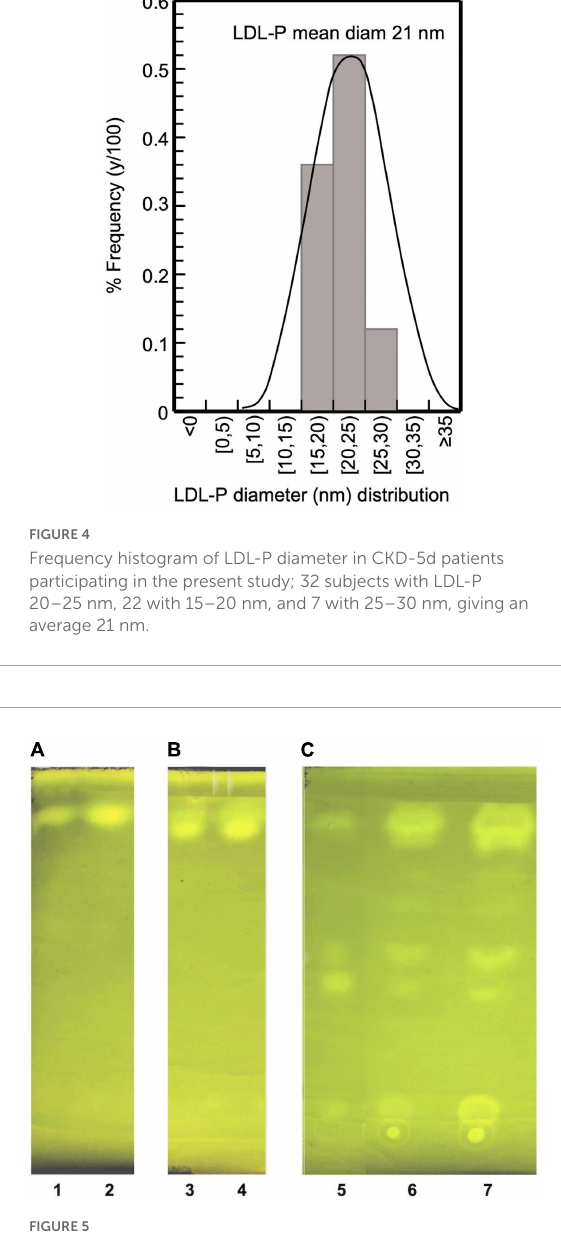
FIGURE5 Thin layer chromatography of LDL lipid sub-fractions. (A) LDL cholesteryl esters (lane 1: 1 × moles, lane 2: 2 × moles); (B) LDL triglycerides (lane 3: 1 × moles, lane 4: 2 × moles); and (C) LDL free cholesterol (lane 5: pure cholesterol standard solution, lane 6: 1 × moles LDL free cholesterol, lane 7: 2 × moles LDL free cholesterol).